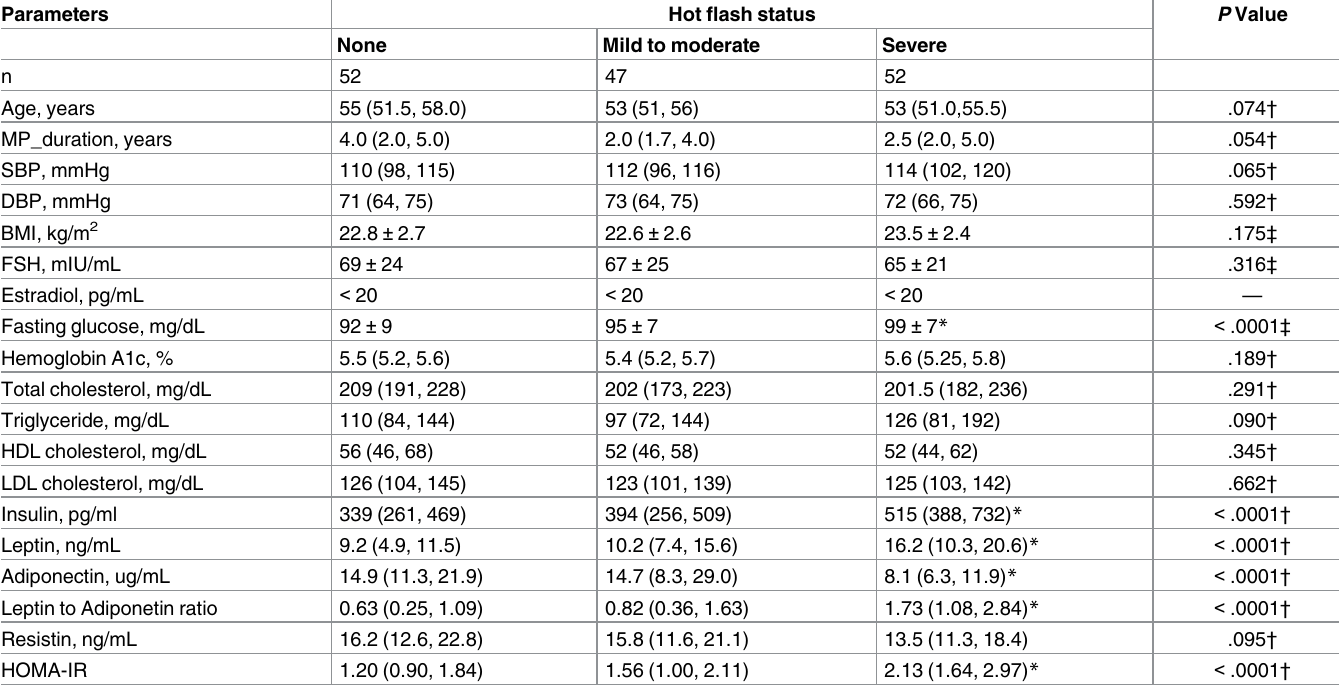
Table 1. Characteristics of the participants by hot flash